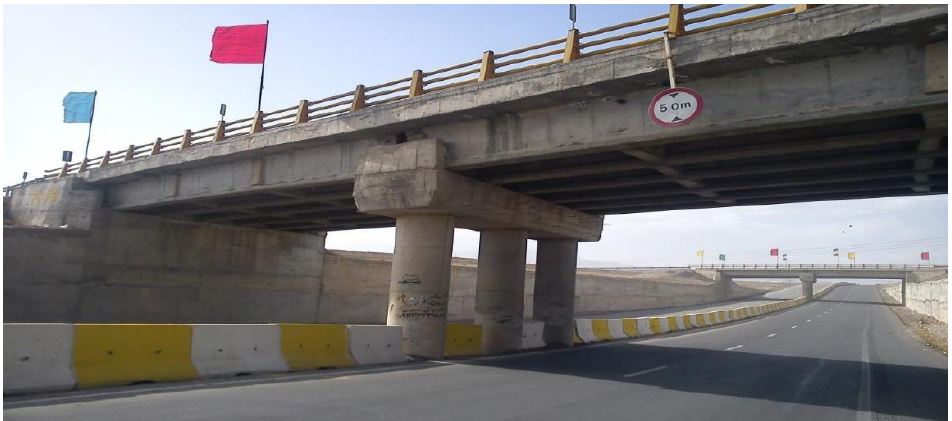
Figure 10. The structural elements of bridge No. 2.